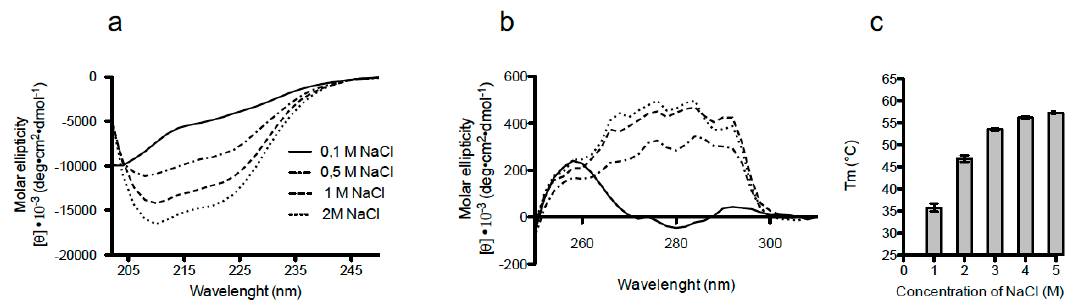
Figure 5. Salt-dependent folding of Ht BVMO. ( a ) Far-UV and ( b ) Near-UV Circular Dichroism spectra of 0.1 mg/mL enzyme in 50 mM TRIS-HCl buffer pH 8.0 in the presence of increasing concentrations of NaCl (0.1–2.0 M). ( c ) Thermal stability of Ht BVMO measured in solutions at increasing molarity of NaCl.